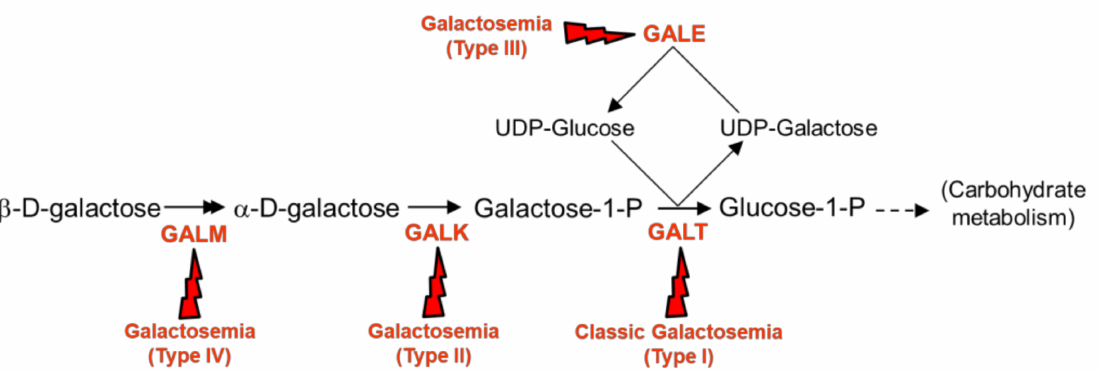
Figure 1. Structure of the model of the homodimeric GALT enzyme carrying the mutation p.Gln188Arg. Chain A is in blue; chain B, in orange. The residues of the two active sites are represented in stick form and colored in magenta, with the mutant residue in black. Galactose-1- phosphate (G1P) is in green, and 5,6-dihydrouridine-5’-monophosphate (H2U) is in cyan. Zn ions are represented as yellow spheres. The surface of the central cavity of the enzyme is represented in grey.